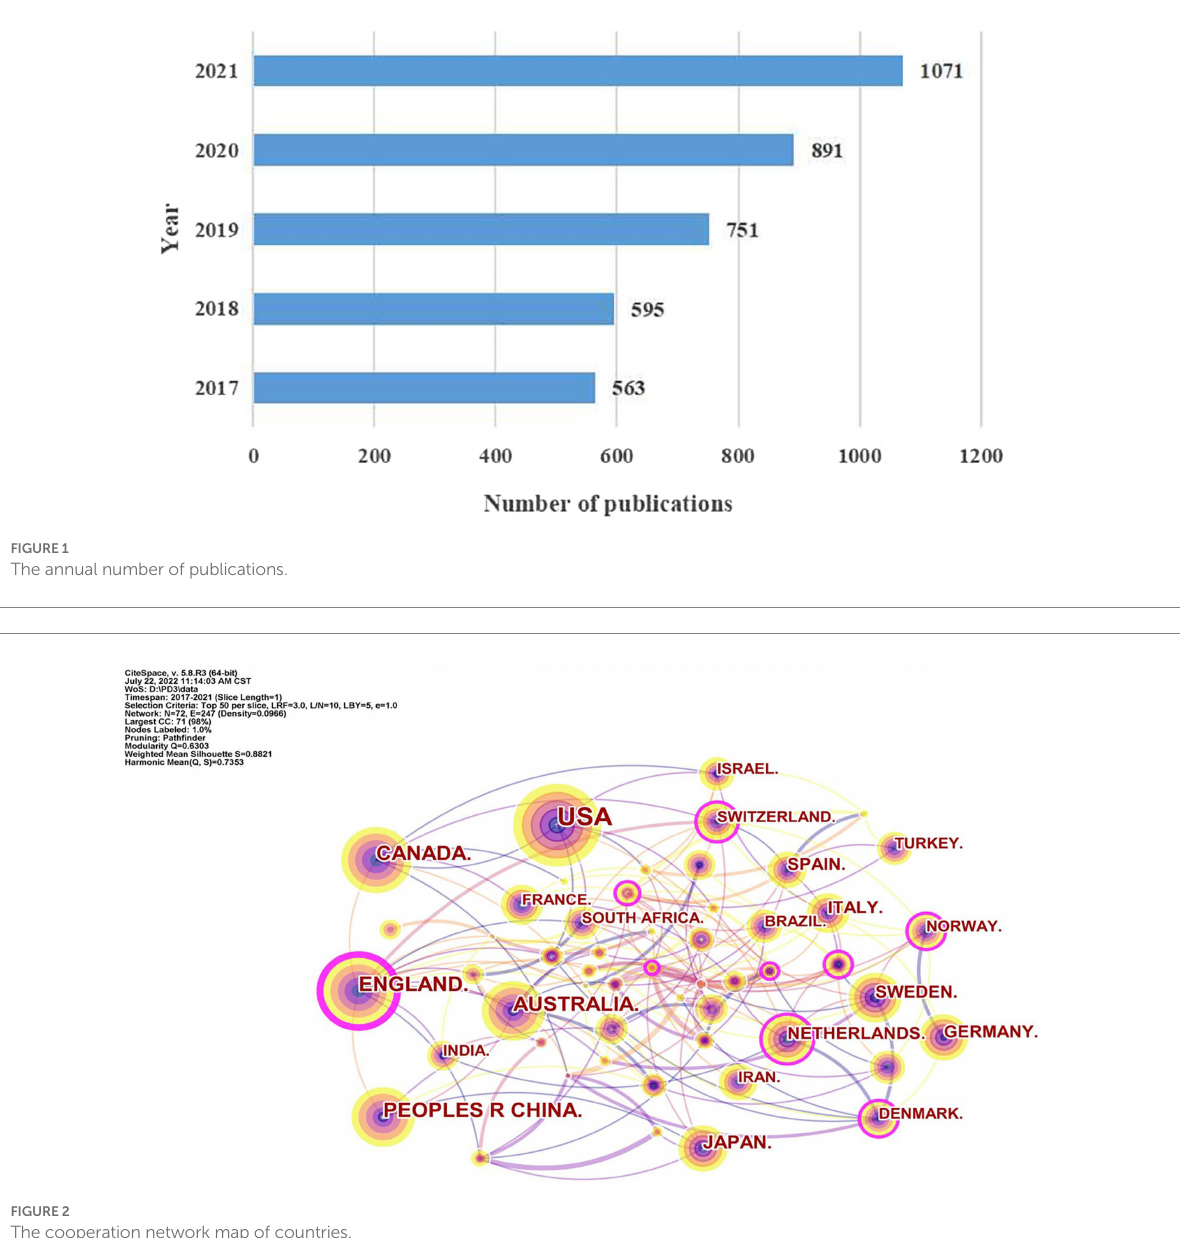
Figure 3 is the cooperation network map of institutions.